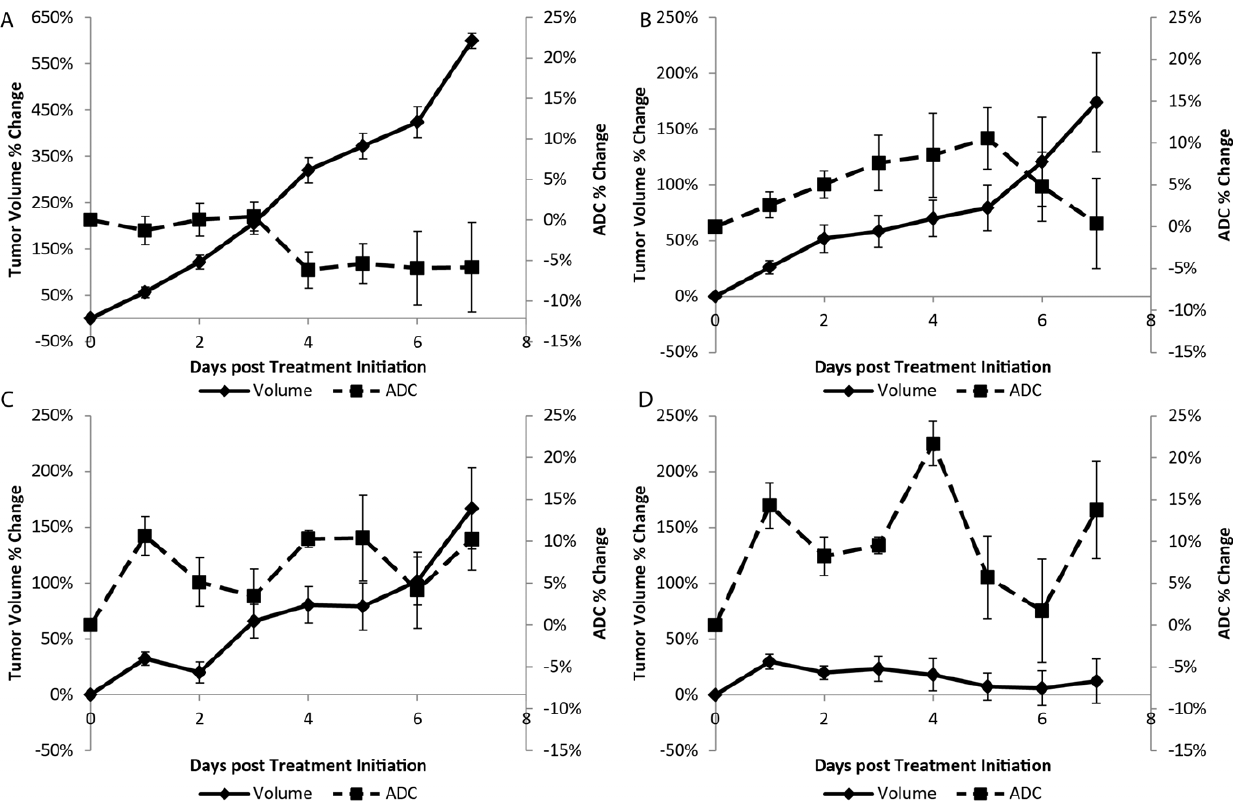
Figure 5. Plots of the percent change in tumor volume and normalized ADC (ADC) for each of the treatment groups in Study2 . Presented are treatment groups (A) Control, (B) irradiation (IR), (C) gemcitabine (GEM) and (D) combination gemcitabine and irradiation (GEM + IR). Data is presented over the first week of the study as the mean 6 SEM.